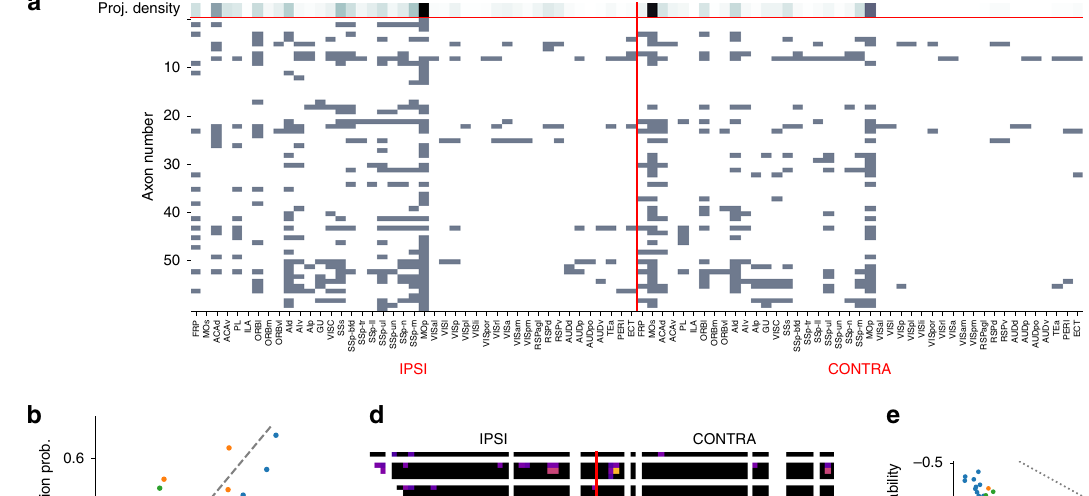
(Fig. 5d), with some strengths exceeding a 15-fold increase. However, there were several problems preventing us from simply using these observed interactions to constrain connectivity. First, we only had data for axons originating from one of 43 brain regions and it is likely that interactions differ for source regions. Second, the data were incomplete, as some targeted regions were not innervated by a single reconstructed axon (Fig. 5d, white patches), and others were based on only a single or two axons. Third, evaluating 86·(86 − 1)/2 = 3655 potential interactions based on only 61 data points (i.e., axons) are statistically inherently unstable and likely to dramatically over fi t.